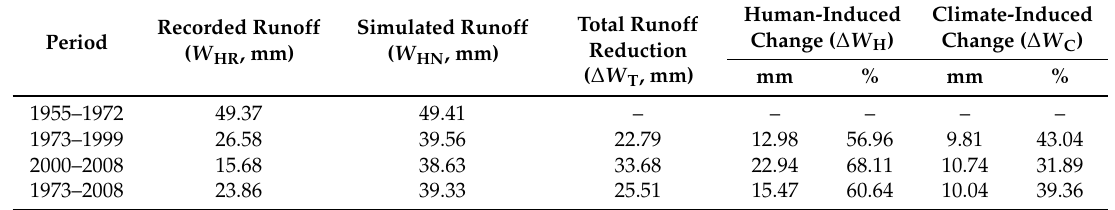
Table 2. Impacts of climate change and human activities on runoff of the Xinshui River